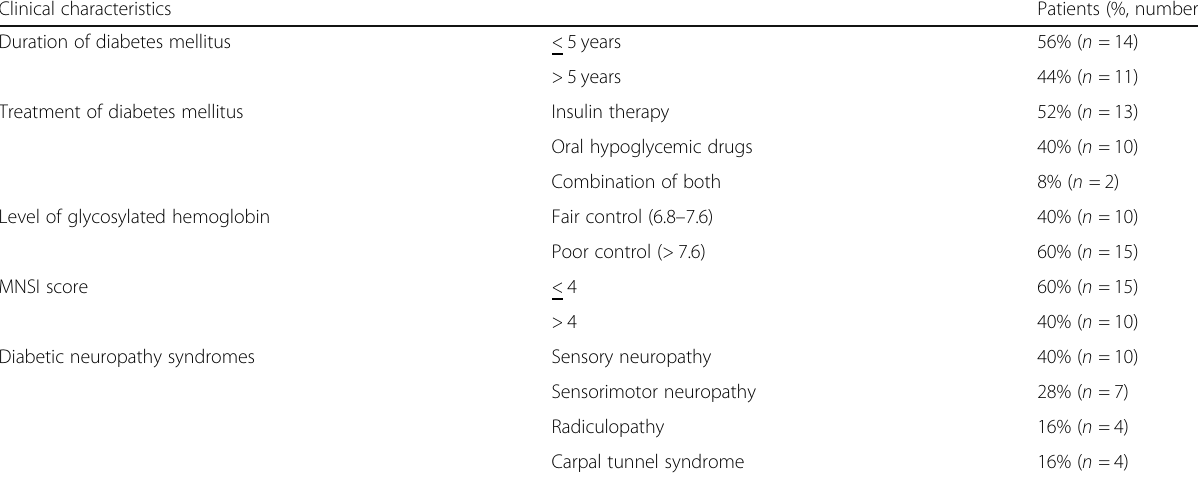
Table 2 Clinical characteristics of diabetic peripheral neuropathy patients Clinical characteristics